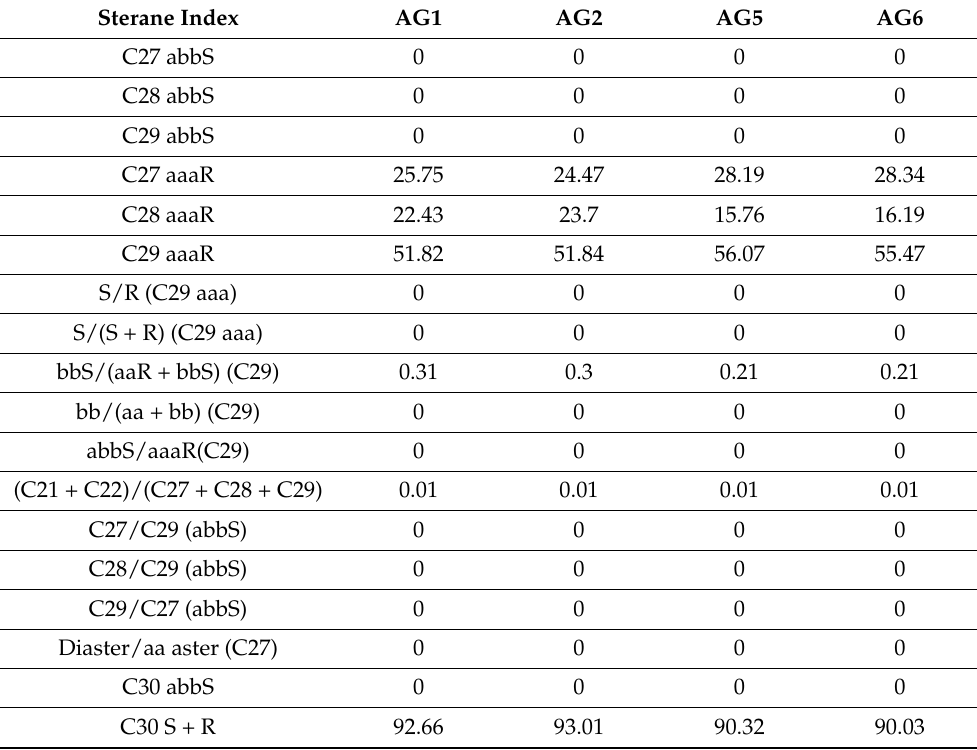
Table 9. Geochemical sterane